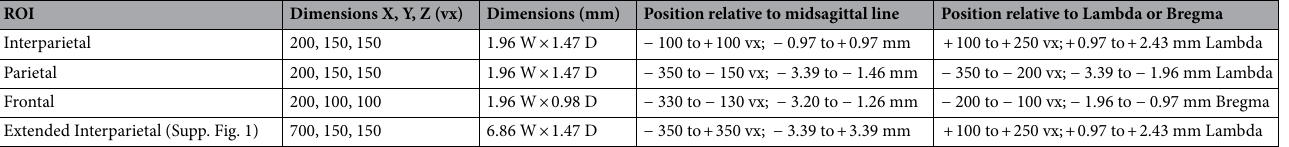
Table 1. Region of interest (ROI) dimensions and